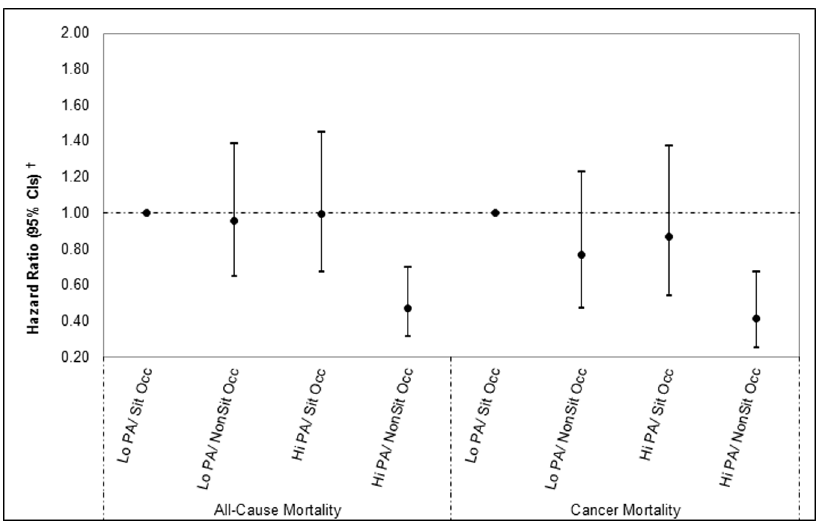
Figure 1. The combined association of main activity at work and non-occupational physical activity in women (N=5214). Lo PA/Sit Occ: Low physical activity/Sitting occupation; Lo PA/NonSit Occ: Low physical activity/standing or walking occupation; Hi PA/Sit Occ: High physical activity/Sitting occupation; High physical activity/standing or walking occupation. { Adjusted for age, self-reported general health, alcohol drinking frequency, cigarette smoking, prevalent cardiovascular disease at baseline (angina/stroke/ischaemic heart disease), prevalent cancer at baseline,